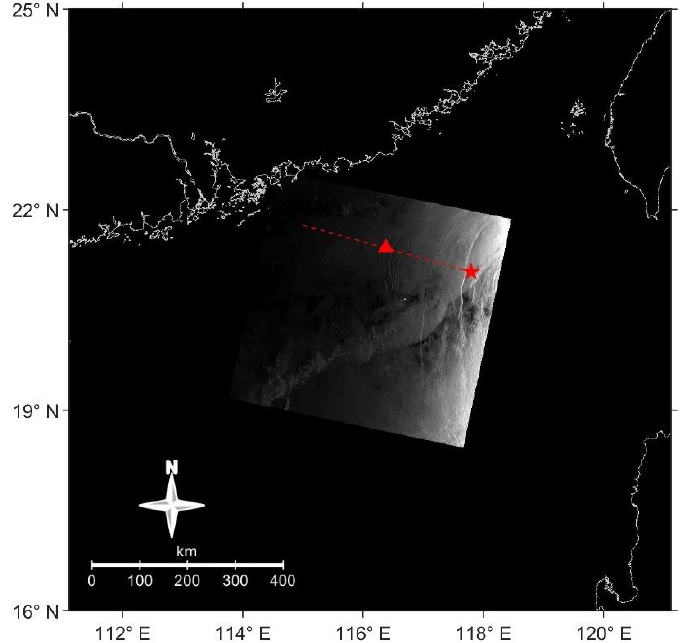
Figure 6. Satellite image of the Environment satellite (Envisat) taken at 02:17 UTC on 23 May 2011, 26.3 h after the ISW was measured by the shipboard ADCP. The red pentagram represents the location where the ISW was captured by the ship, the dashed line represents the propagation path, and the red triangle represents the same ISW 26.3 h after it was detected in the satellite image.